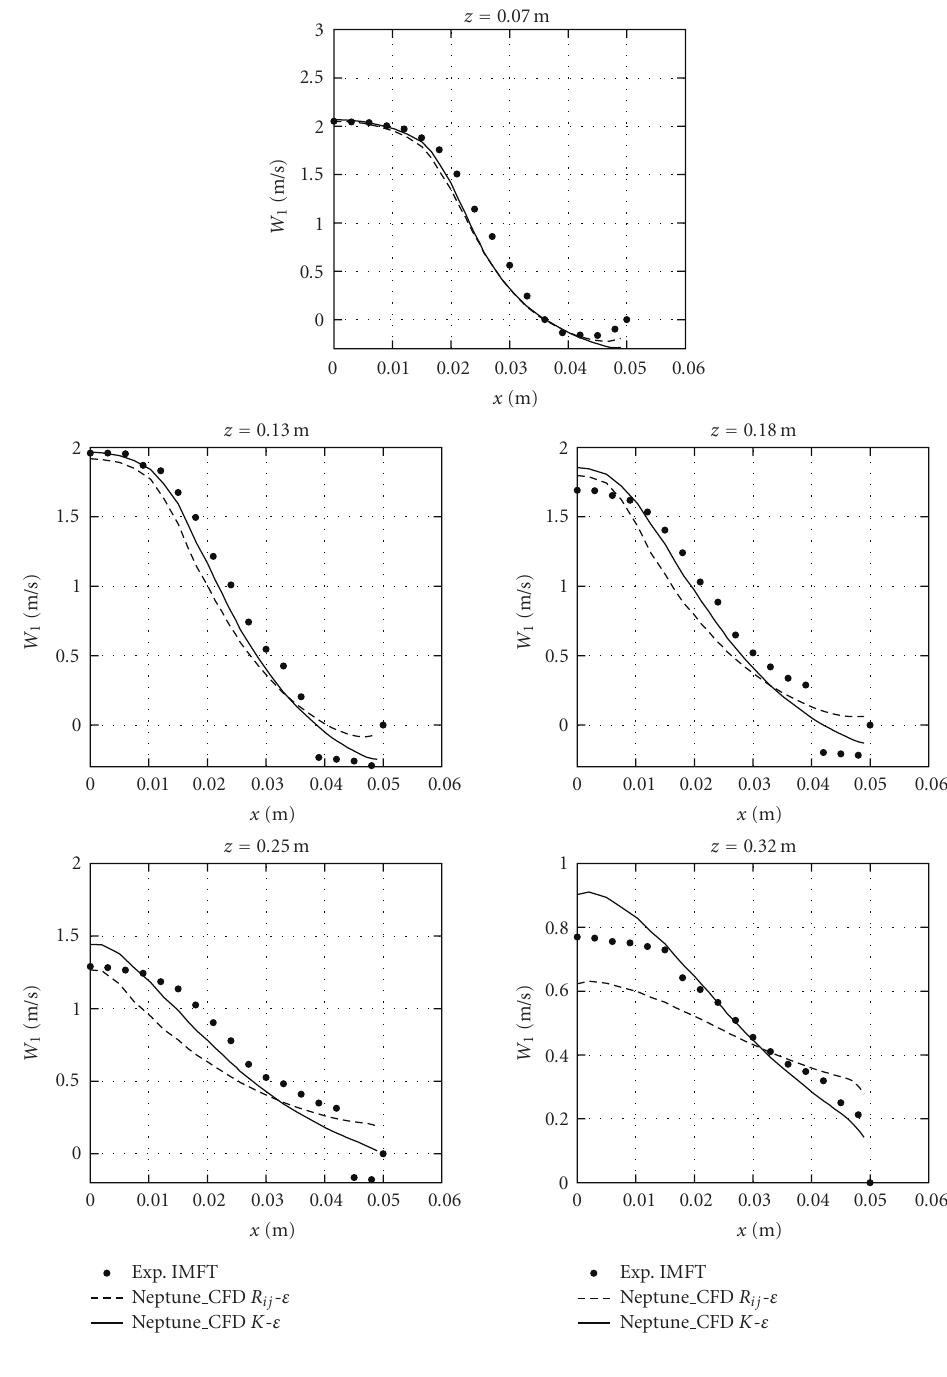
Figure 7: Liquid mean axial velocity